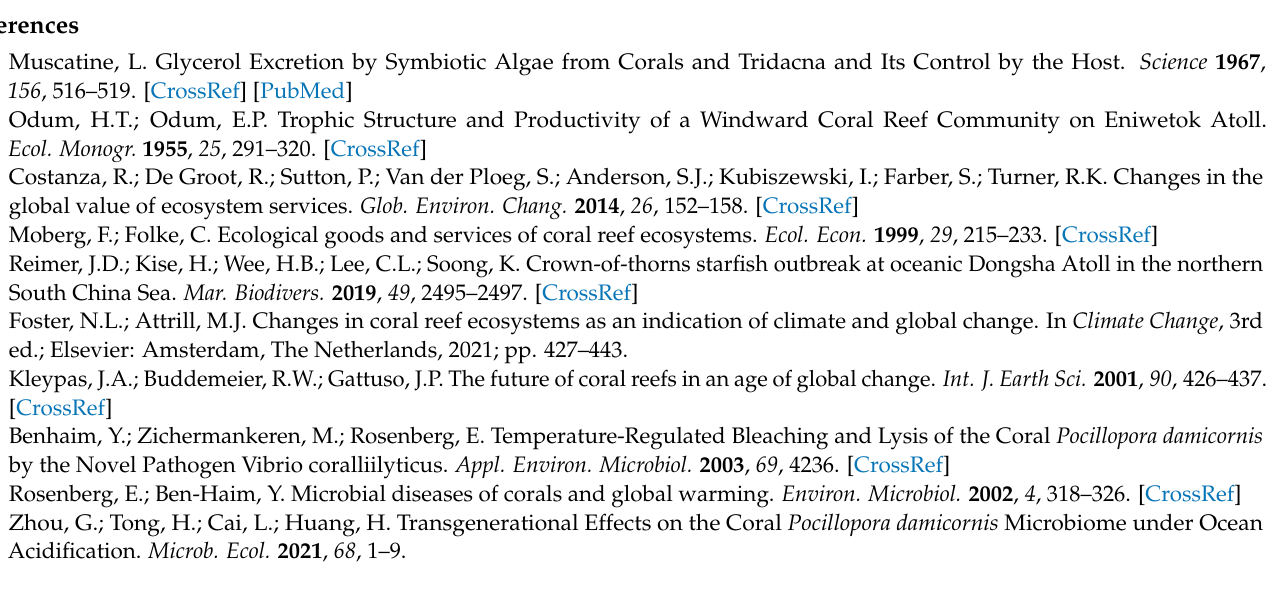
distribution statistical results, Figure S3: CCS reads distribution statistical results, Figure S4: FLNC distribution statistical results, Figure S5: Consensus reads distribution statistical results, Figure S6: Seven database annotation statistical results, Figure S7: Gene functional annotation Venn diagram, Figure S8: Annotation statistical results of coral full-length transcriptome according to the NR database, Figure S9: Annotation statistical results of zooxanthellae full-length transcriptome ac- cording to the NR database, Figure S10: Annotation statistical results of coral and zooxanthellae full-length transcriptome according to the GO database, Figure S11: Annotation statistical results of coral and zooxanthellae full-length transcriptome according to the KOG database, Figure S12: Annotation statistical results of coral and zooxanthellae full-length transcriptome according to the KEGG database, Figure S13: SSR distribution results of coral and zooxanthellae, Figure S14: Gene GO enrichment DAG of biological process, Figure S15: Gene GO enrichment DAG of cellular compo- nent, Figure S16: Gene GO enrichment DAG of molecular function, Table S1: Statistical results of polymerase read and subread, Table S2: Statistical results of CCSs and FLNCs, Table S3: Statistical results of unigene number corresponding transcripts, Table S4: Statistical results of sequence length distribution after de-redundancy, Table S5: Statistical annotation results of symbiont, coral and zooxanthellae, Table S6: Reads comparison results of coral and zooxanthellae, Table S7: Different expression level gene number statistical results of coral, Table S8: Different expression level gene number statistical results of